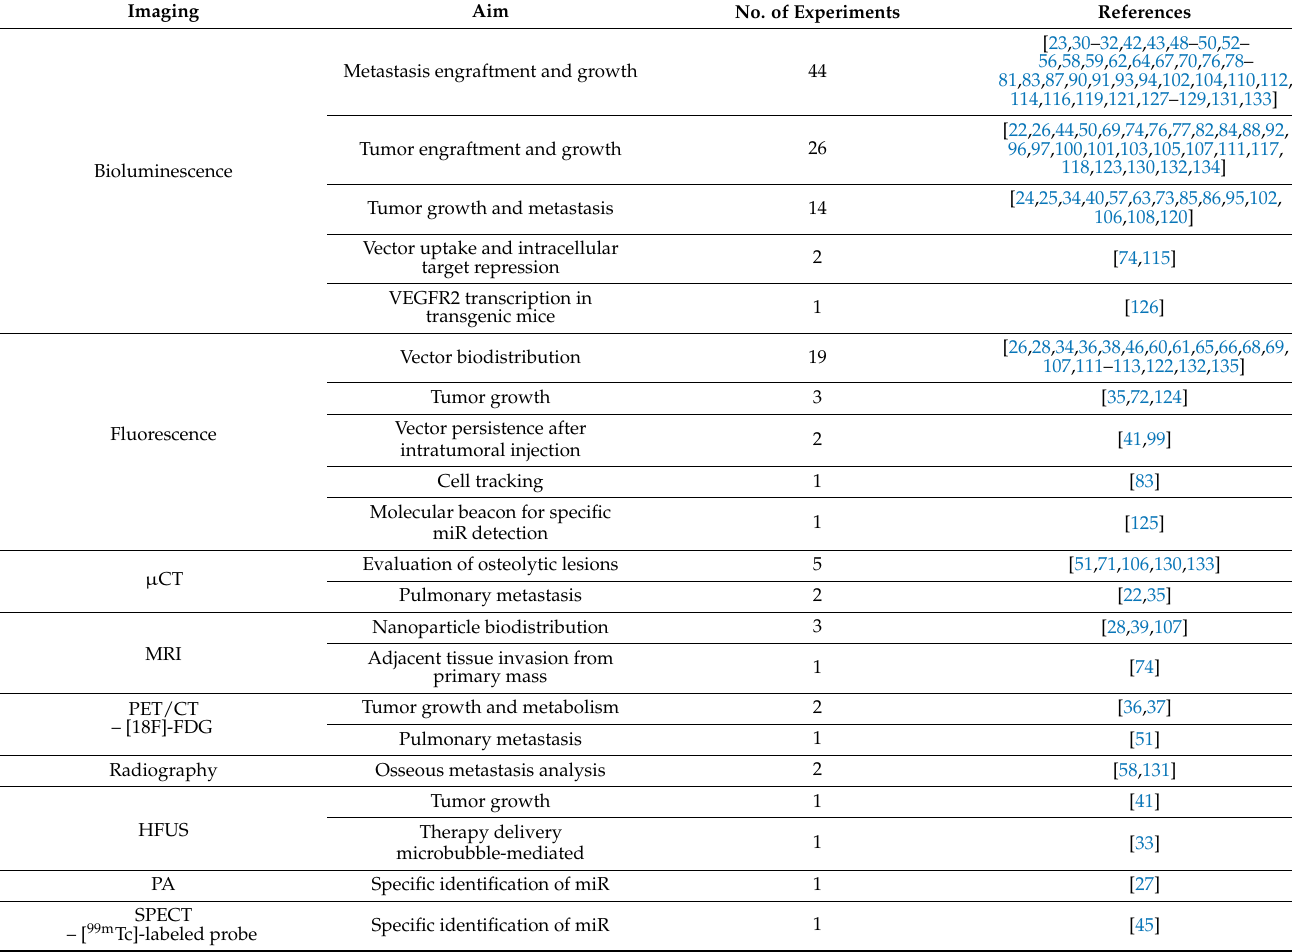
FDG: fluorodeoxyglucose; HFUS: high-frequency ultrasonography; µ CT: microcomputed tomography; MRI: magnetic resonance imaging; PA: photoacoustic; PET/CT: positron emission tomography/computed tomography; SPECT: single-photon emission computed tomography; and VEGFR2: vascular endothelial growth factor receptor